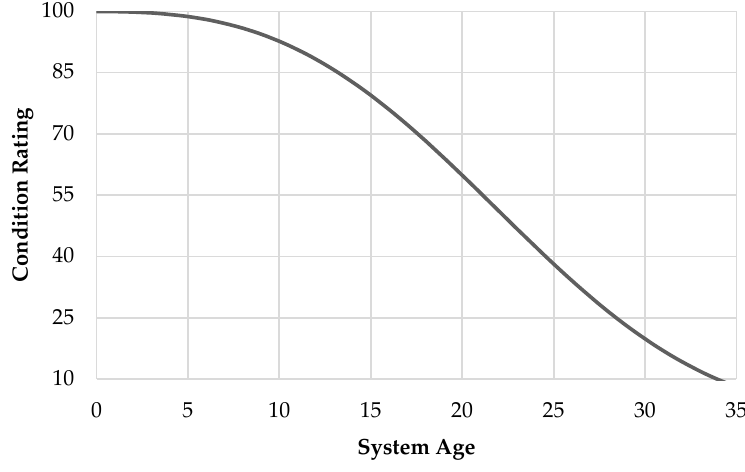
Figure 8. Weibull distribution-based deterioration.